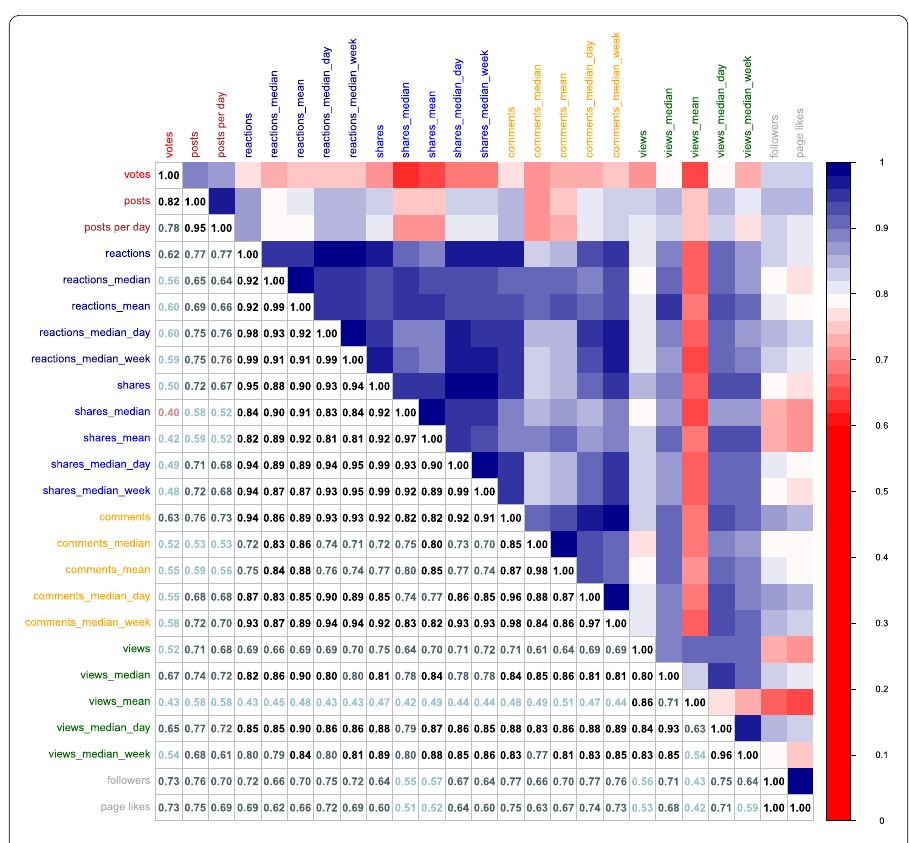
Figure 5 Pearson correlation between Country Ideology